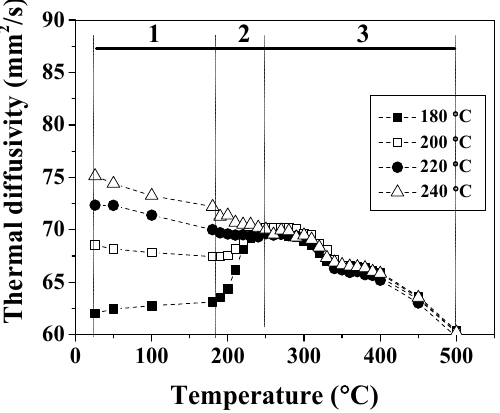
Figure 9. Thermal diffusivity changes of Al-3.5Mg 2 Si samples according to the temperature increase with various contents and aging treatment conditions.